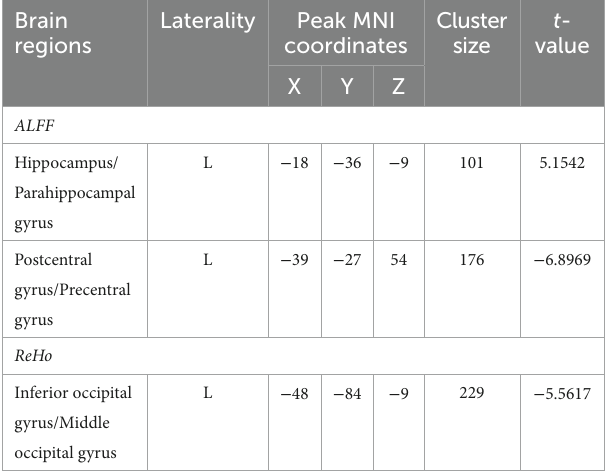
TABLE 3 Brain regions with significantly different functional activity between patients and healthy controls (voxel-level p < 0.001 and cluster- level p < 0.05 with GRF